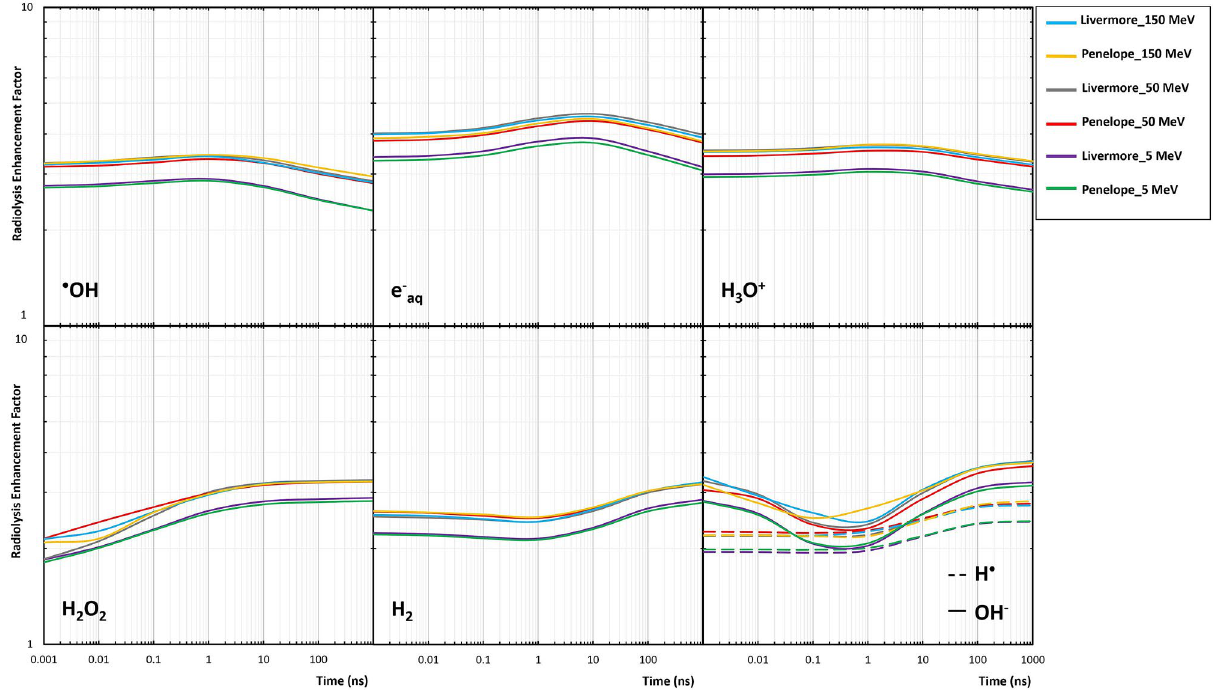
Figure 8. Comparison of the REF between the Livermore and Penelope models obtained for 5, 50, 150-MeV proton beams as a function of time.